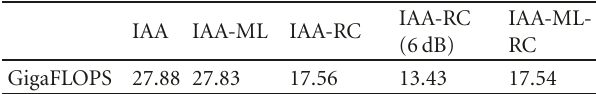
Table 1: Computational